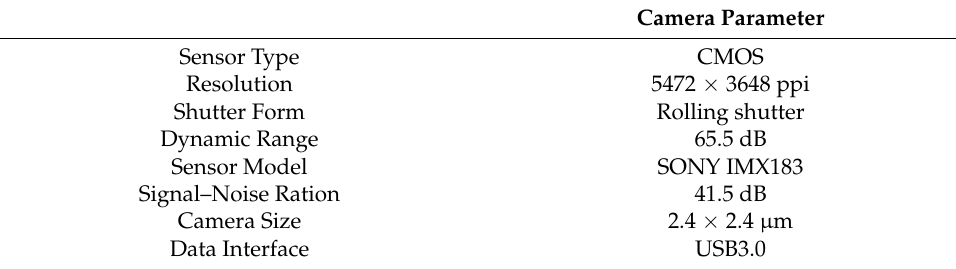
Table 1. Main specifications of the camera.